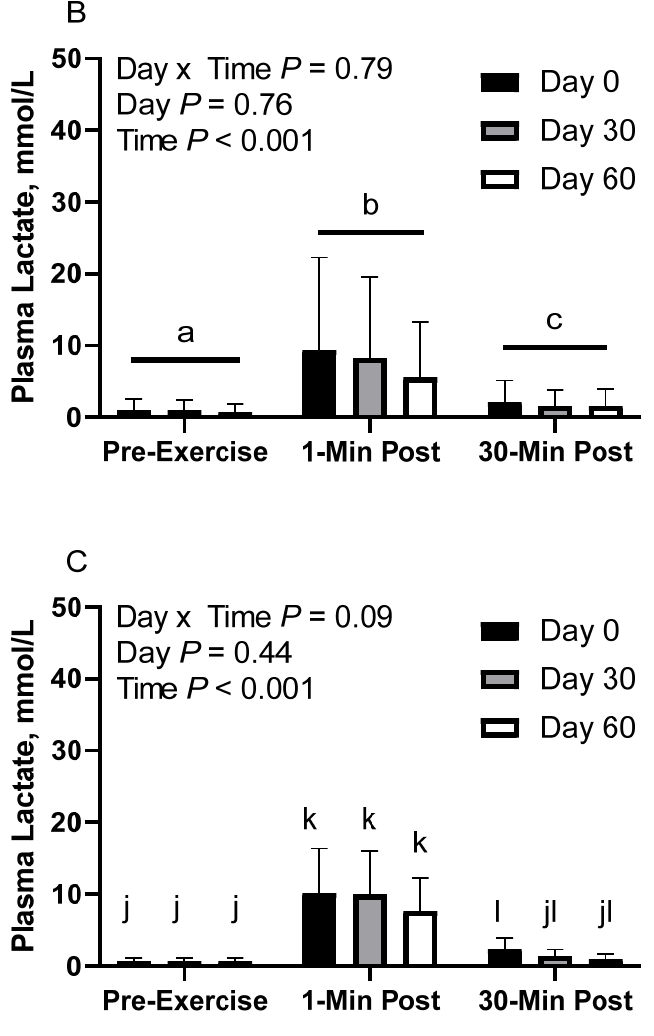
Figure 2. Geometric mean [LCI, UCI] fasting, 1 min post-exercise, and 30 min post-exercise plasma lactate concentrations in young horses fed 60% energy from hay (coastal bermudagrass) and 40% energy from concentrate (SafeChoice Original, Cargill Animal Nutrition, St. Paul, MN, USA) on d 0, 30, and 60 of a 60 d feeding trial. Where CON ( A ) did not receive dietary alteration, FLAX ( B ) had 25% of concentrate calories replaced with a flaxseed oil blend, and RICE ( C ) had 25% of concentrate calories replaced with crude rice bran oil. a,b,c Means not sharing a superscript differ p < 0.05. j,k,l Means not sharing a superscript differ p < 0.09.